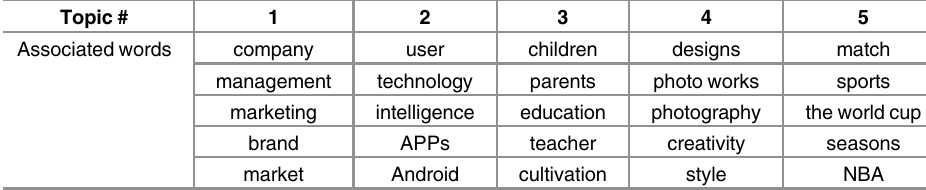
Table 2. Examples of topics and associated words extracted by